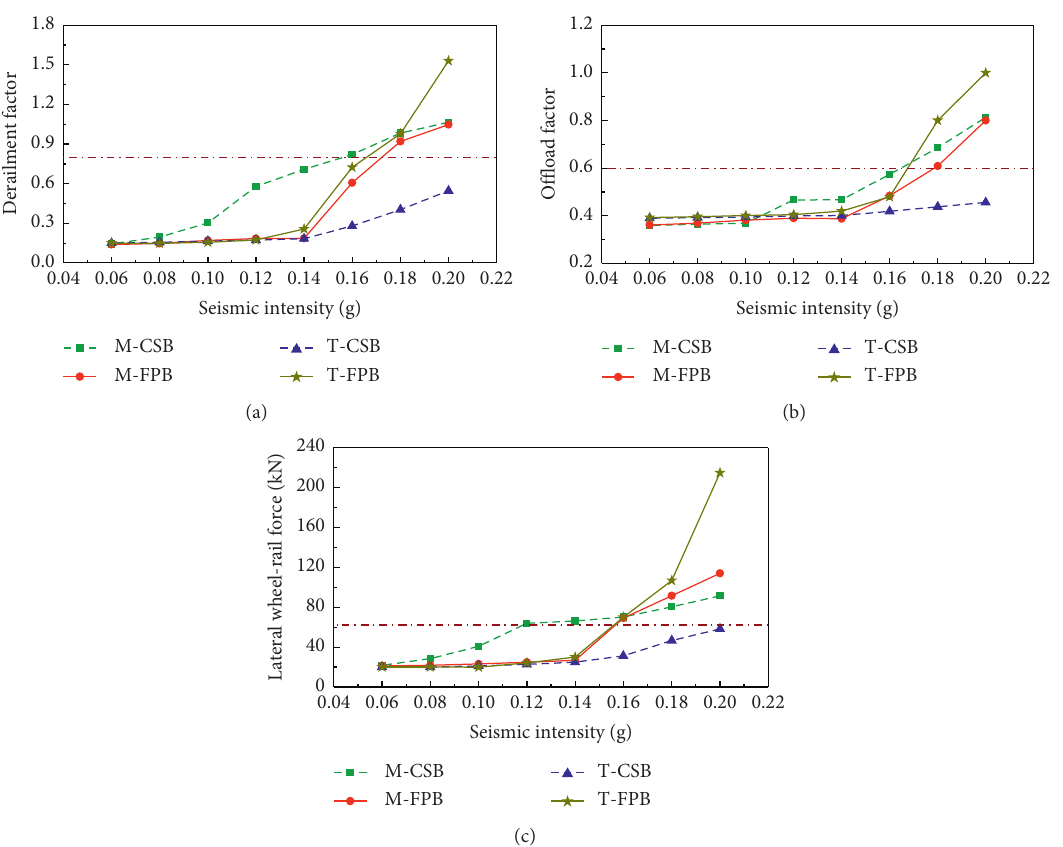
Figure 13: Distributions of running safety indices of the train versus seismic intensity. (a) Derailment factor. (b) Offload factor. (c) Lateral wheel-rail